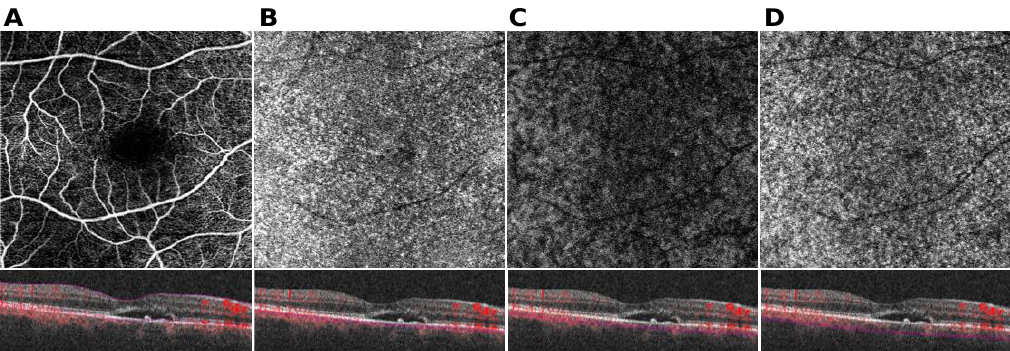
Figure 1. Optical coherence tomography angiography (OCTA)-Imaging of the posterior pole in a subject with Central Serous Chorioretinopathy. En face angiogram and corresponding B-scan at the level of the full retina ( A ), choriocapillaris ( B ), Sattler’s layer ( C ), and Haller’s layer ( D ).